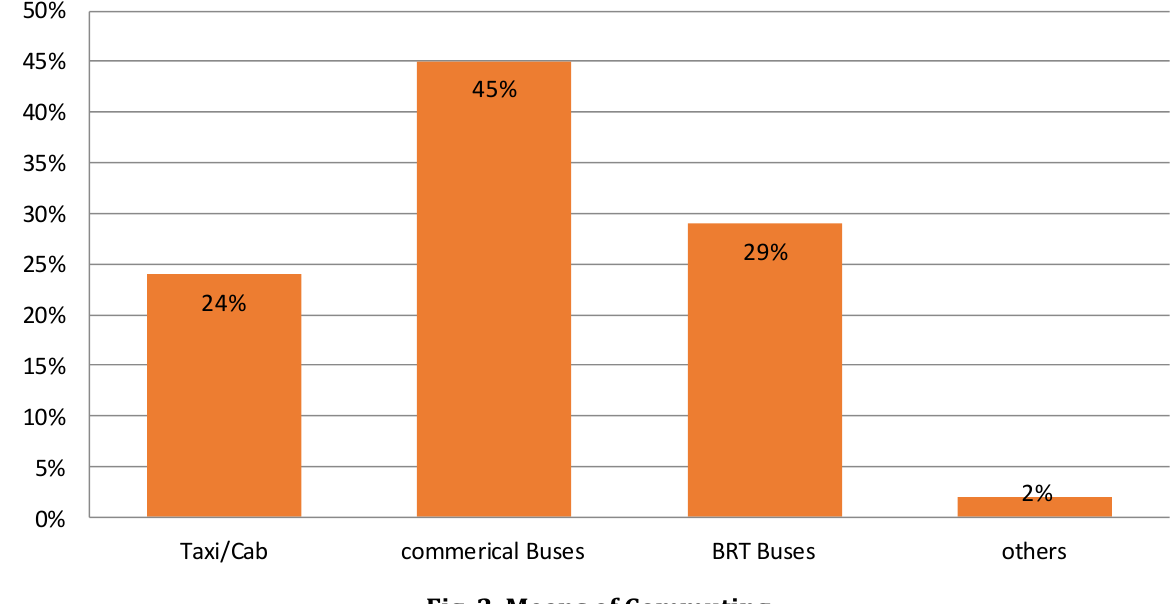
Fig. 2. Means of Commuting Source: field Survey,